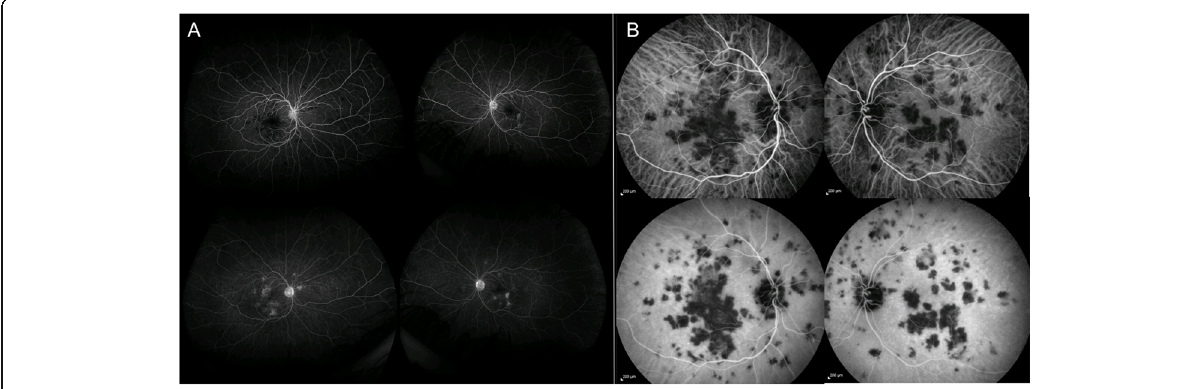
Fig. 3 Acute Posterior Multifocal Placoid Pigment Epitheliopathy. A Ultra-wide field fluorescein angiography of both eyes showing hypofluorescent lesions in the early phases (right panel, top images), becoming hyperfluorescent in the late frames (right panel, bottom images). B Indocyanine angiography of both eyes showing hypofluorescent spots across all phases (left panel, top images: early phases, left panel, bottom images: late